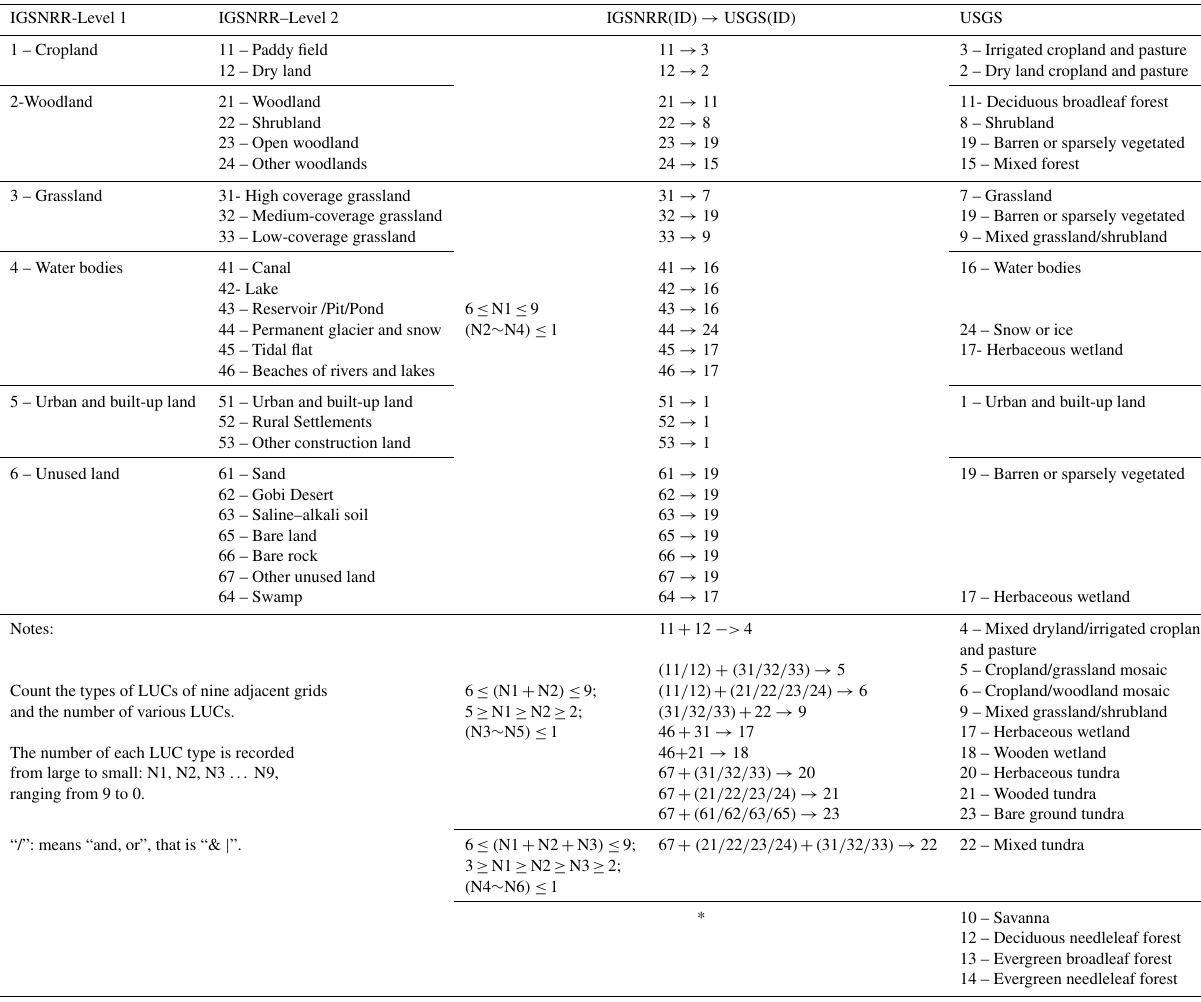
Table 1. Rules for converting the classification standard of LUCs from IGSNRR to